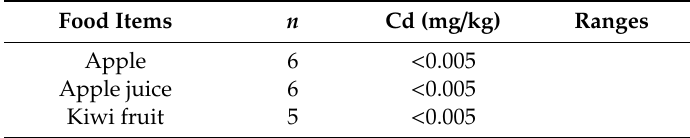
Table 9. Cadmium (Cd) concentrations in fruit. Data are presented as arithmetic means.